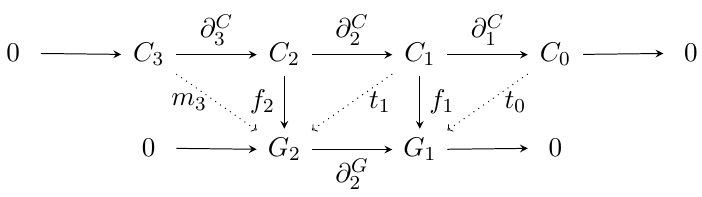
Figure 9 . Chain complexes for the 1 ; 2-gauge model. The con(cid:12)gurations maps are f 2 for faces, f 1 for links, the gauge transformations are the t 0 , t 1 ; while the 2-holonomies are given by m 3 , the 1-holonomies by m 2